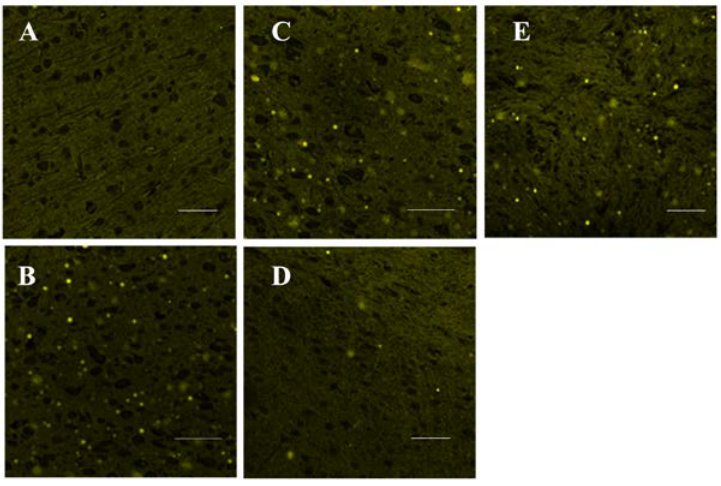
Figure 4. Representative photographs of Nile-red staining (400×). ( A ) control group; ( B ) SA group; ( C ) low dose TGP group; ( D ) high dose TGP group; ( E ) positive group. Scale bar = 50 μm.